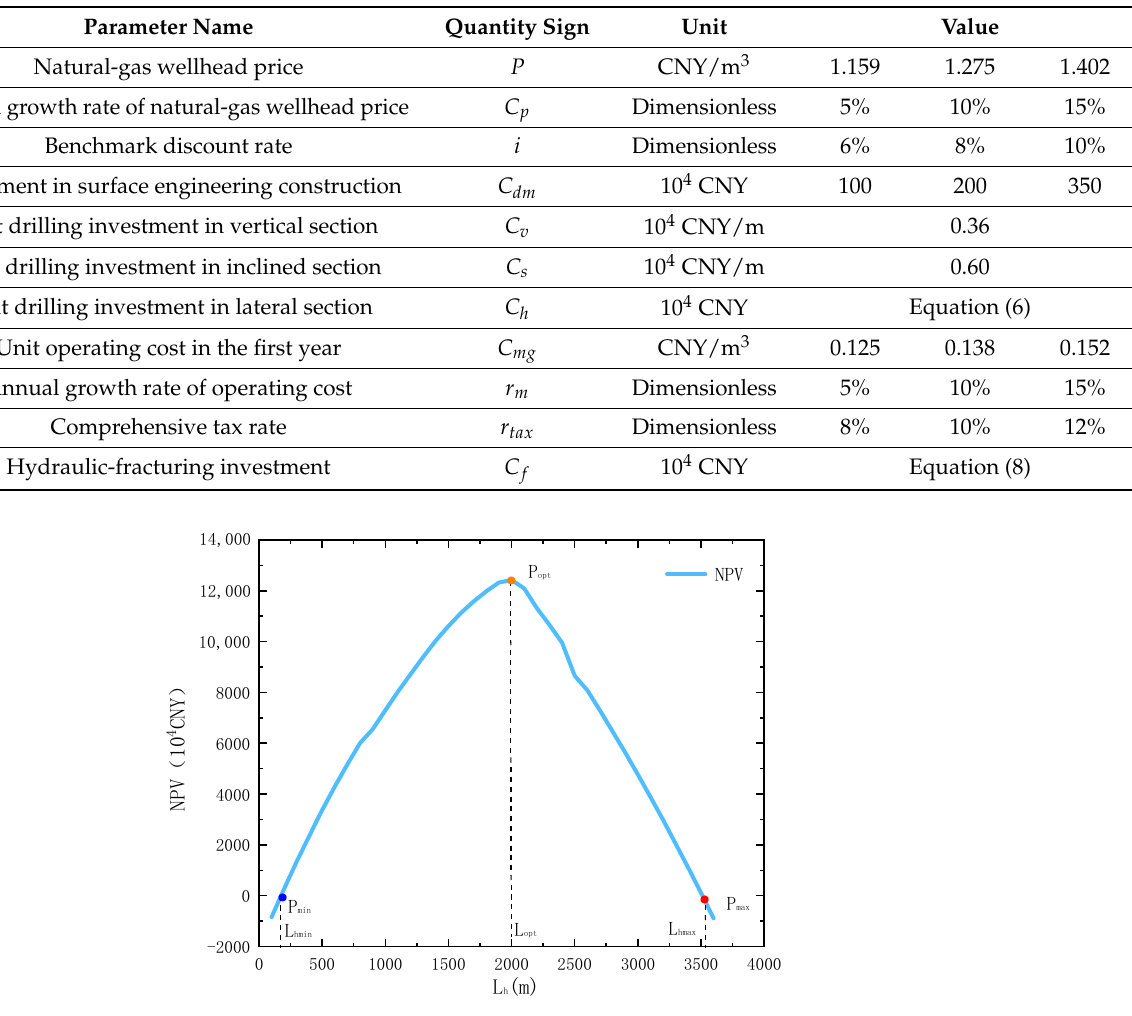
Figure 4. Relationship curve between the NPV and lateral length when the half-length of the fracture is 180 m. Figure 4 has three points: P min , P opt , and P max . The NPV corresponding to the P min point